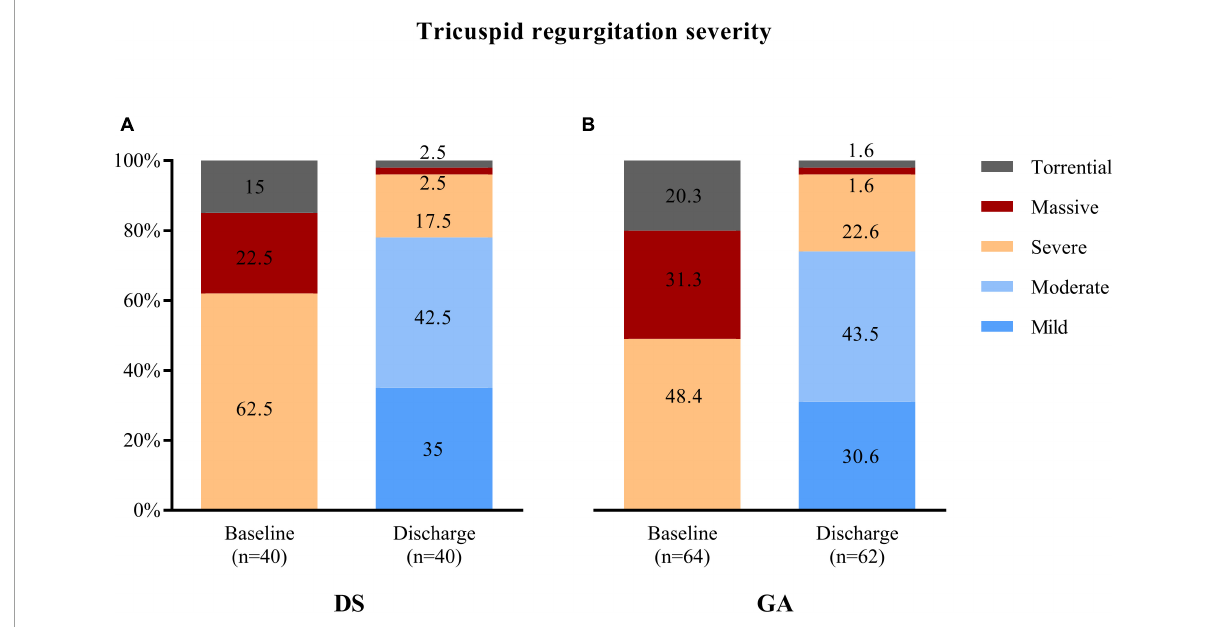
FIGURE1 Tricuspid regurgitation (TR) severity was similarly reduced at discharge after transcatheter tricuspid valve repair using (A) deep sedation (DS) or (B) general anaesthesia (GA).